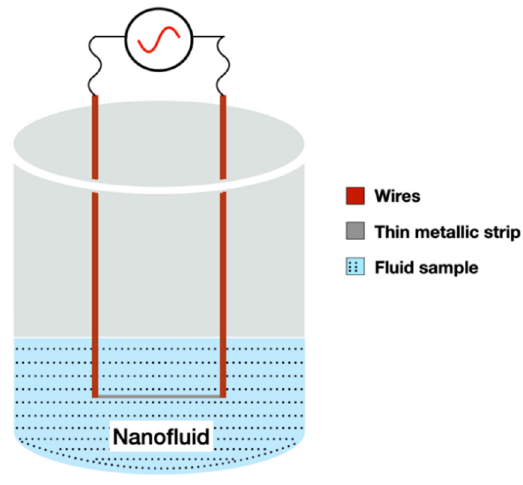
Figure 7. Schematic representation of the 3ω method.